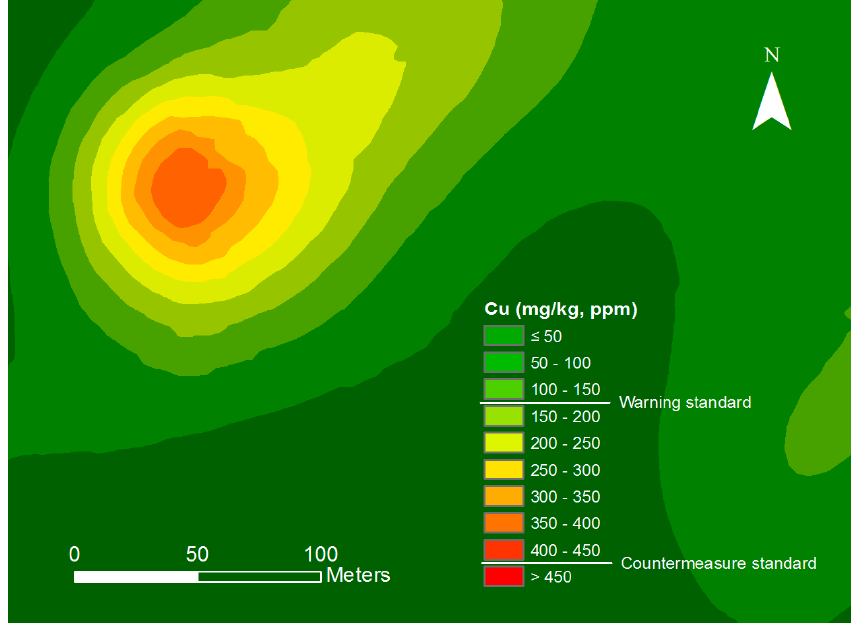
Figure 3. Spatial distribution map of Cu with levels of soil contamination exceeding the Korea Soil Contamination Warning Standards or Countermeasure Standards (modified from Suh et al. [13]).